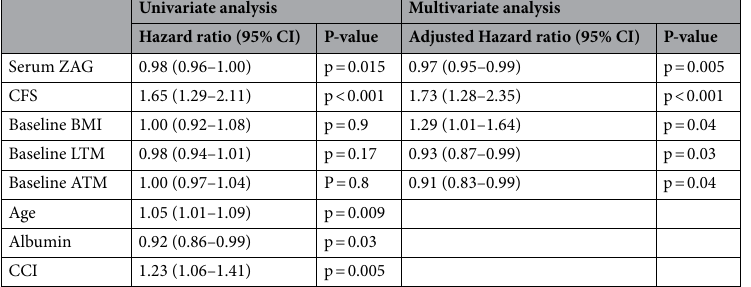
Univariate analysis Multivariate